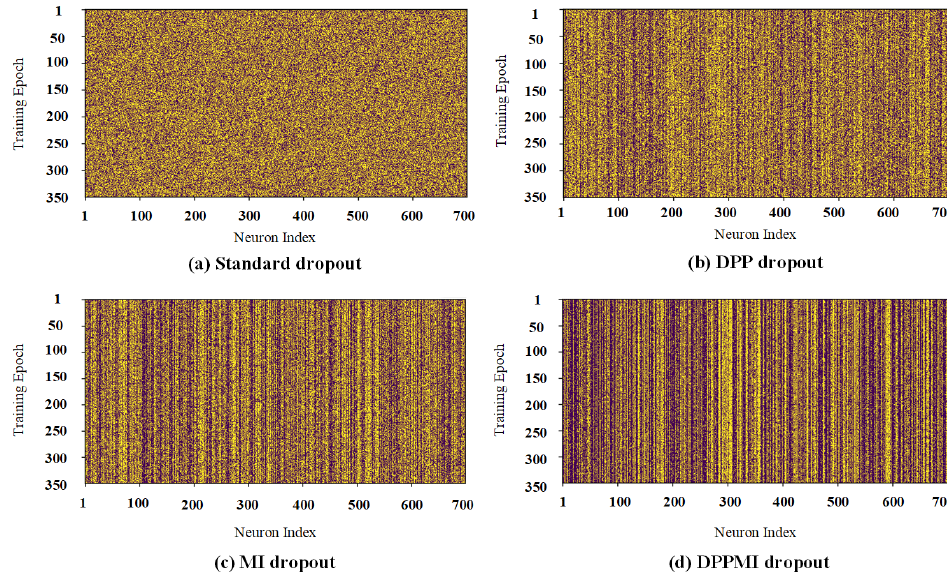
Figure 7. Activation maps of the first dense layer in ( a ) Standard dropout; ( b ) DPP dropout; ( c ) MI dropout; ( d ) DPPMI dropout. Yellow and purple pixels depict active and inactive neurons,